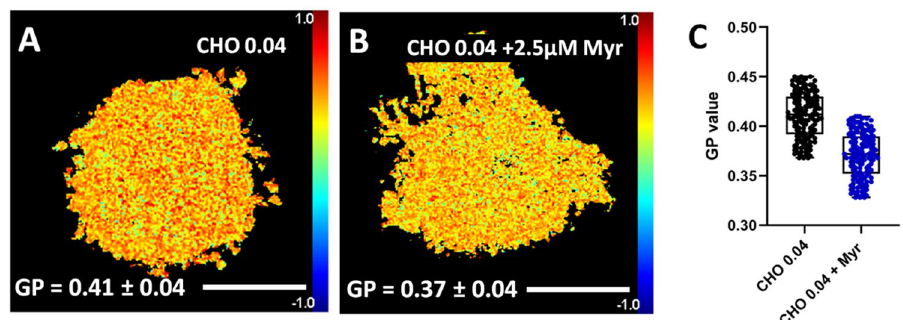
Figure 4. Two-photon microscopy images of PM patches stained with laurdan for GP measurements. PM patches of non-treated ( A ) and myriocin-treated ( B ) CHO cells grown in deficient medium. ( C ) Box plot graph of GP values of non-treated (black) and myriocin-treated (blue) CHO cell PM patches. GP are given as average values ± S.D. Three independent experiments were performed; n = 150 (50 PM patches × 3 replicas). Statistical significance (GP of control vs. myriocin-treated cells) was calculated with the Student’s t-test, P = 0.03. Bar = 30